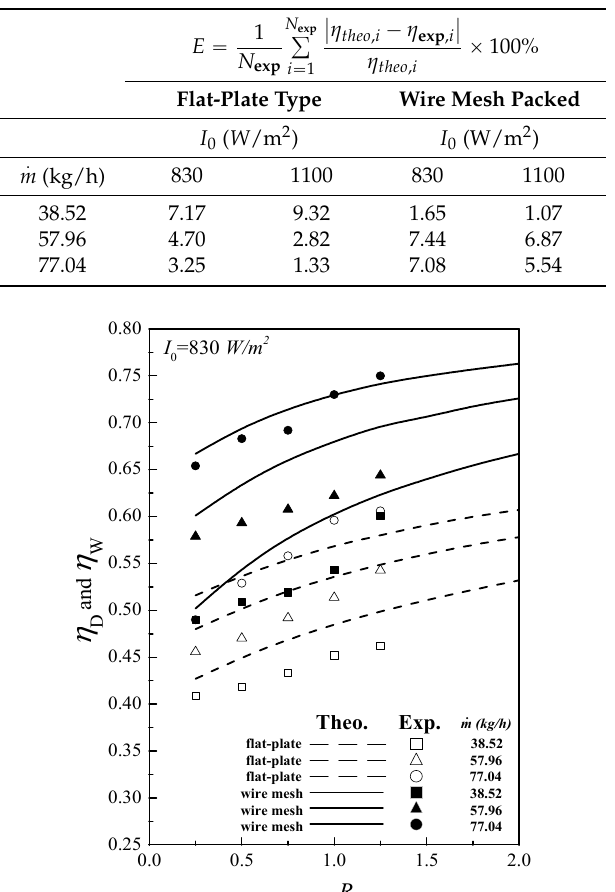
Figure 5. Effects of recycle ratio and air mass flow rate on collector efficiencies ( I 0 = 1100 W/m 2 ).